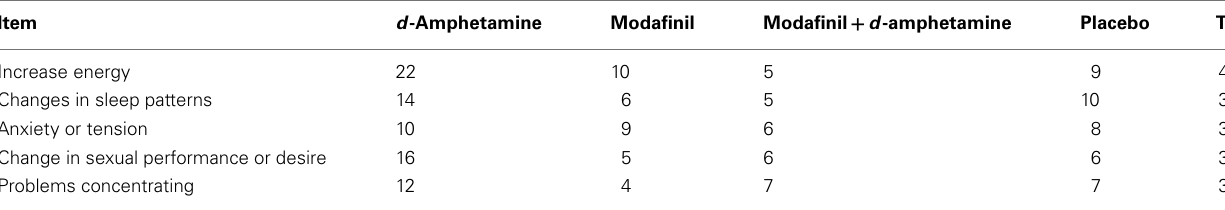
Table 3 | Items most frequently endorsed on the weekly side-effects